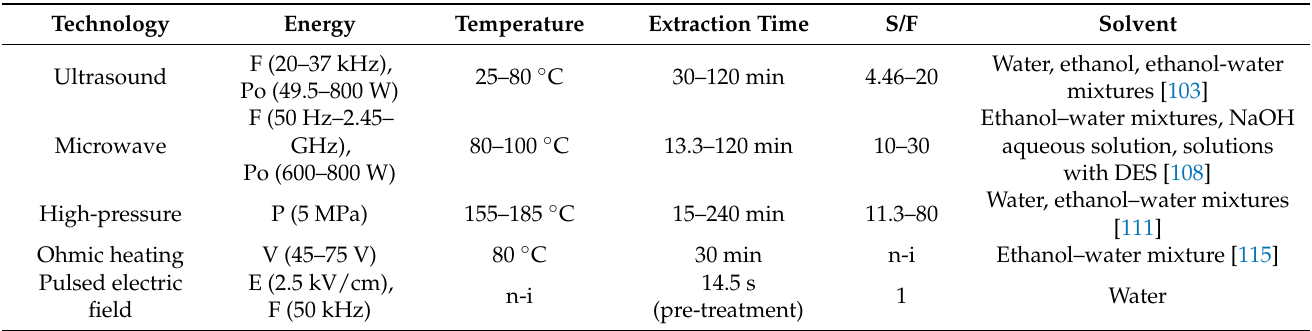
Table 5. Summary of parameters used by each technology to obtain polyphenols and bitter acids from brewing